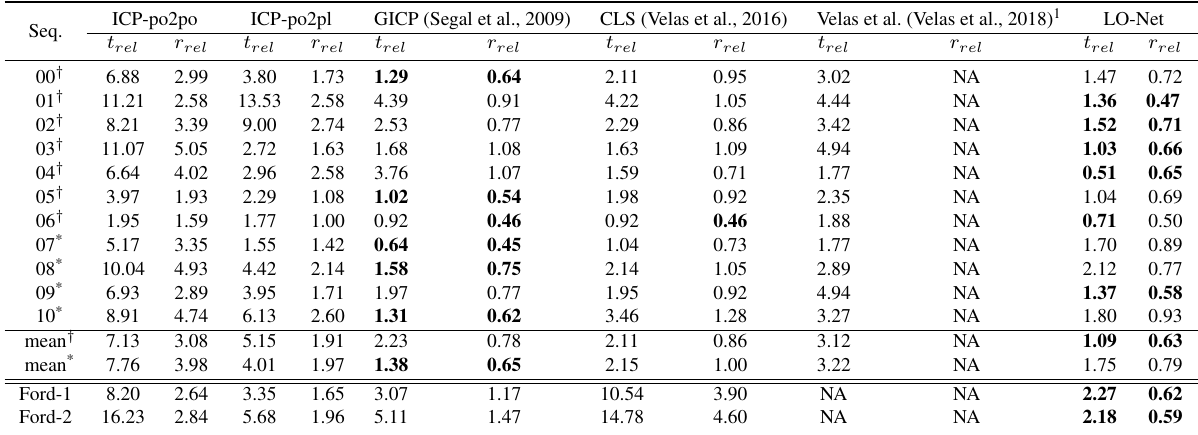
Table 3. Odometry results on KITTI and Ford datasets. Our network is trained on KITTI sequences and then tested on the two